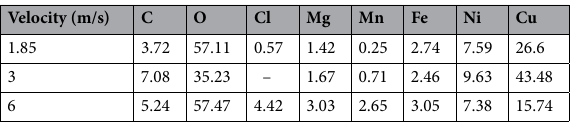
Table 7. The elemental composition of the HAZ of B10 alloy under different seawater flow rates.